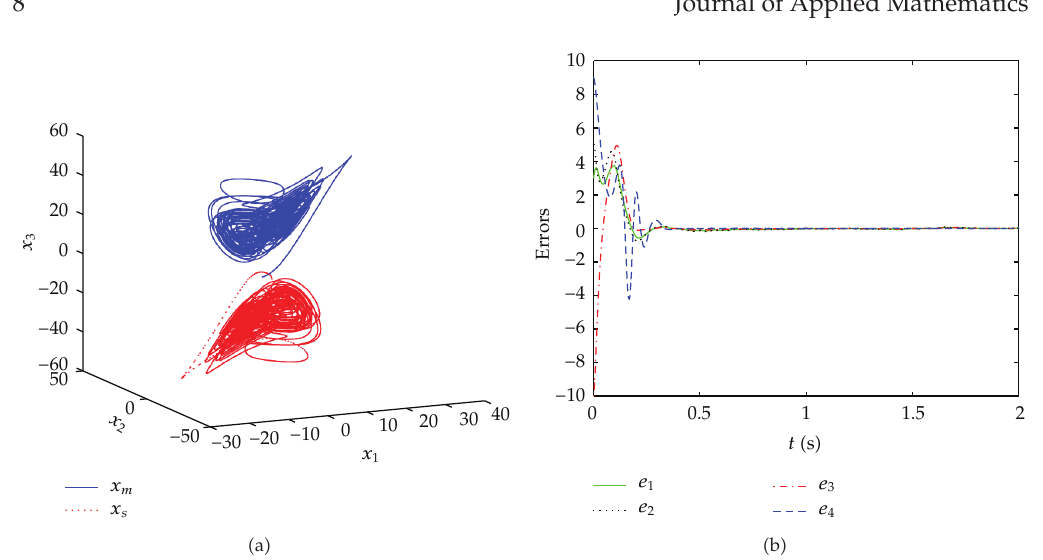
Figure 1: The GPS between systems (cid:2) 4.3 (cid:3) and (cid:2) 4.4 (cid:3) with uncertain parameters as α (cid:7) − 1.